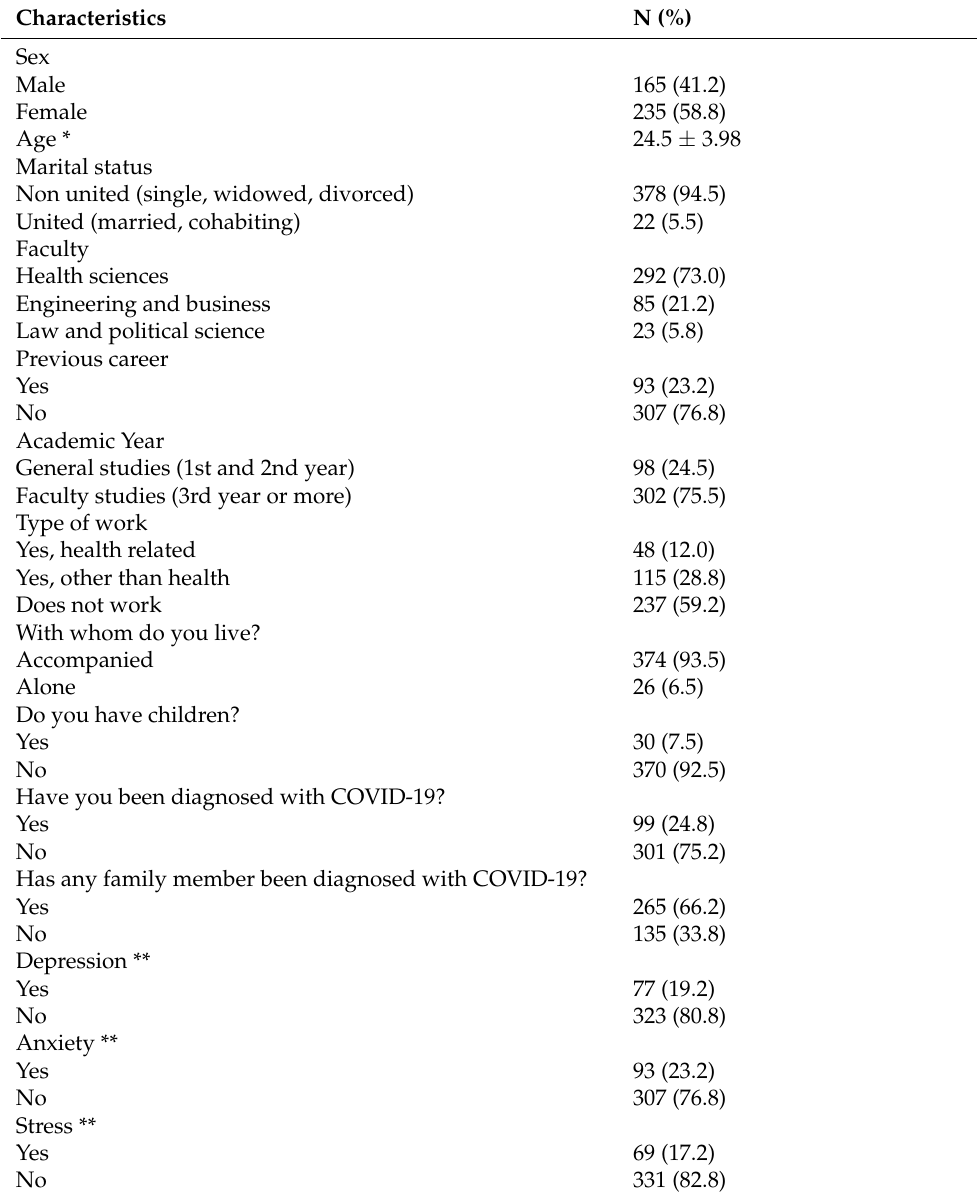
Table 1. Sociodemographic, academic, and clinical characteristics of the